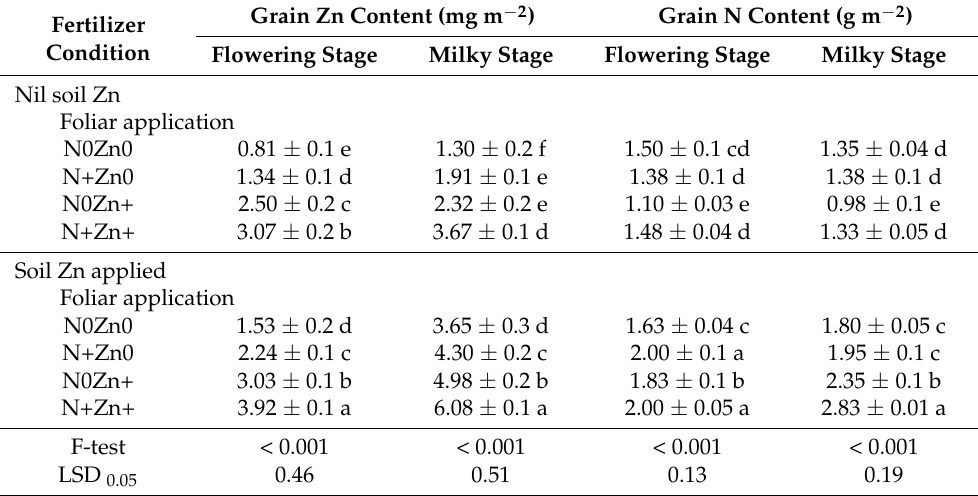
Table 2. Grain Zn and N contents in brown rice SPT1 variety grown at different foliar N and Zn fertilizer rates under variations in soil Zn application at the flowering and milky stages. Each value is the mean of four independent replications ± standard deviation of the mean ( n =